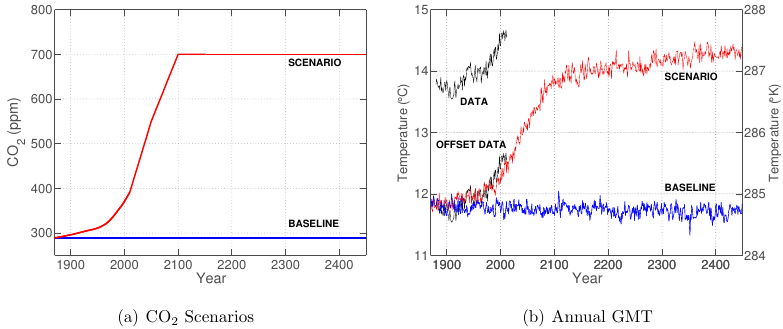
Figure 1. Comparison of modeled and observed global mean temperatures. (a) CO 2 concentrations used in “baseline” and “scenario” runs with the CCSM3 model. (See Appendix A for description of experiments and observations.) Figures here truncate output after less than 600 years but the scenario run extends for 6000 years. (b) Corresponding annual model GMT ( ◦ C) for the two runs and observed GMT from the Global Historical Climatological Network. Model output reproduces trends in global temperature well but with a systematic offset from observations. To better show the similarity in trend we also plot the observational record minus a 2 ◦ C